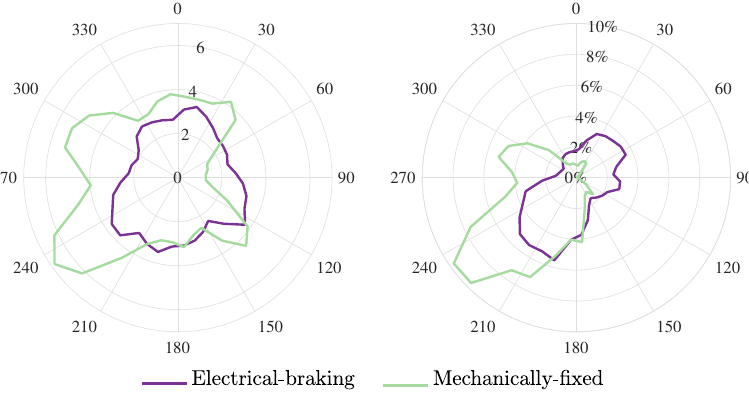
Figure 4. Wind rose data. Left : The average wind speed in (m/s) during the measurements. Right : The distribution of the data in the 18 different bins used, expressed in relation to the total number of samples. The total number of 1s samples is 2.67 × 10 6 for the electrical braking case and 1.27 × 10 6 for the mechanically-fixed